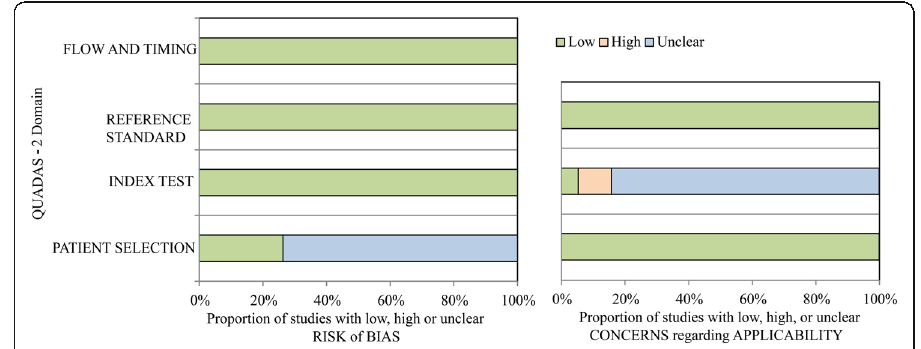
Fig. 3 Assessment of individual risk of bias domains and concerns regarding